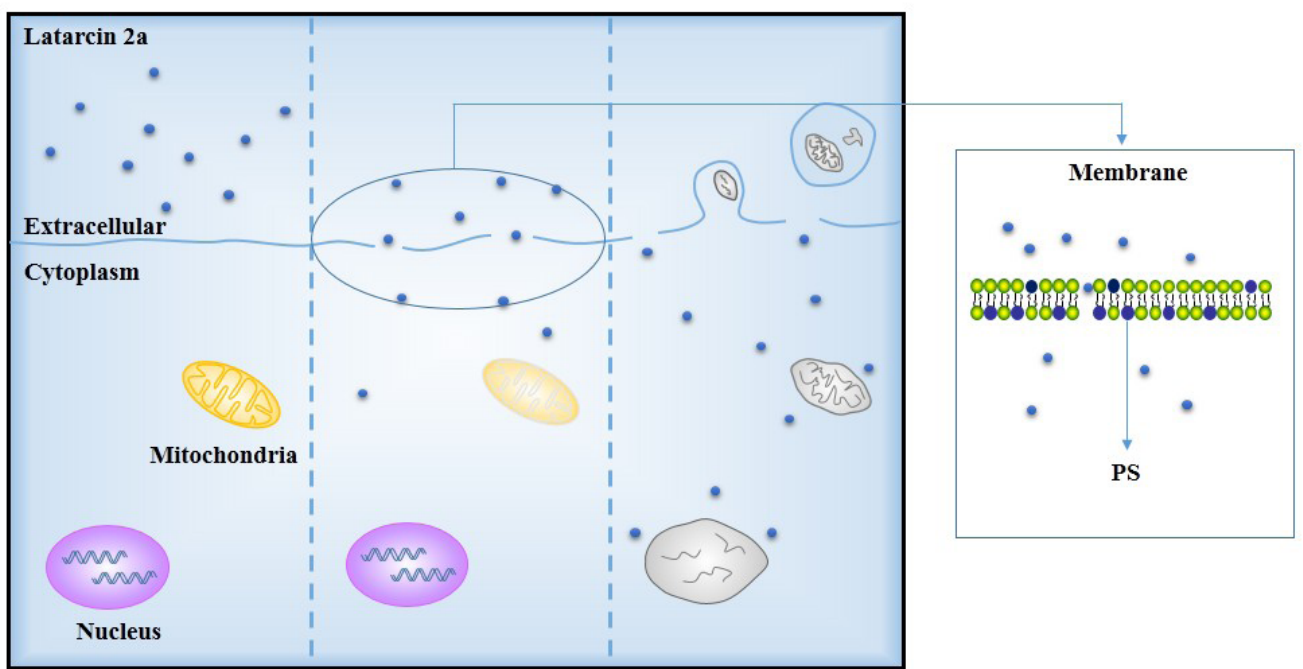
Figure 5. The mechanism of Latarcin 2a interaction with K562 cells . Latarcin 2a bound to membrane and small pores reform in cells membrane. The latarcin 2a penetrated into cytoplasm, which induced inactivation of mitochondria and externalization of PS. There was a positive feedback between externalization of PS and internalization of latarcin 2a. At last, the cell disintegrated due to the high intracellular osmotic pressure caused by accumulation of the peptide. PS: Phosphatidyl